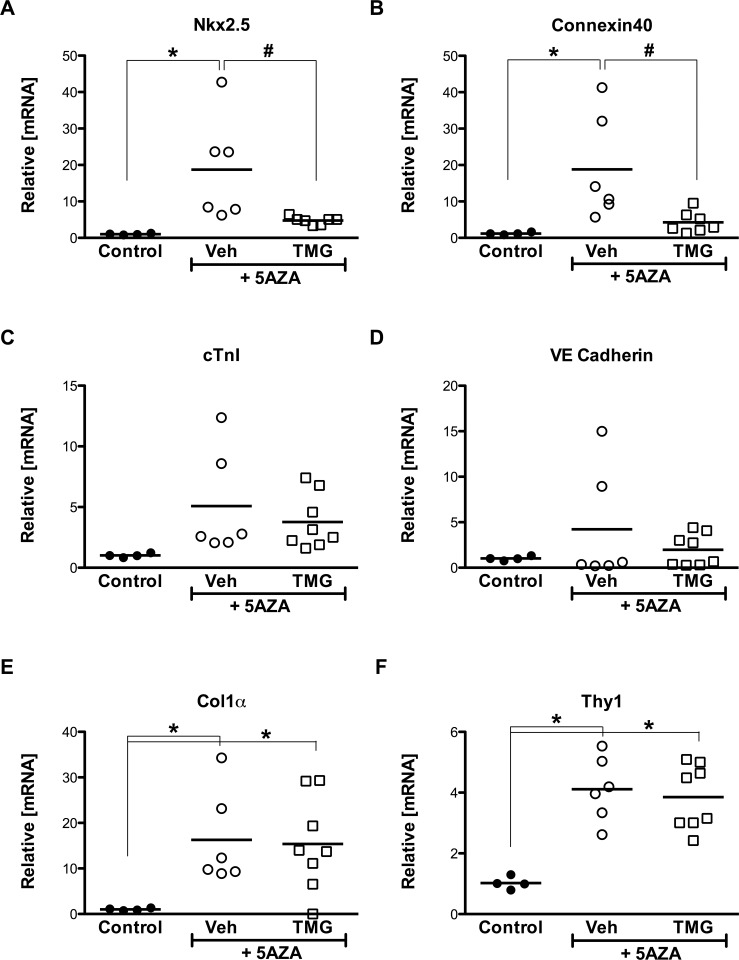
Enhanced O-GlcNAcylation limits cardiomyogenic commitment.
A: Nkx2.5 expression following 5AZA-induced differentiation. B: Significant upregulation of connexin 40 during differentiation. C: Cardiac Troponin I, and D: Endothelial marker VE Cadherin did not change appreciably. E, F: Fibroblast markers Col1α and Thy1 are significantly induced during differentiation. Individual data points are plotted and the horizontal line represents the mean, n>/ = 4/group, *p < 0.05 vs Control; #: p < 0.05 vs Veh (+5AZA).